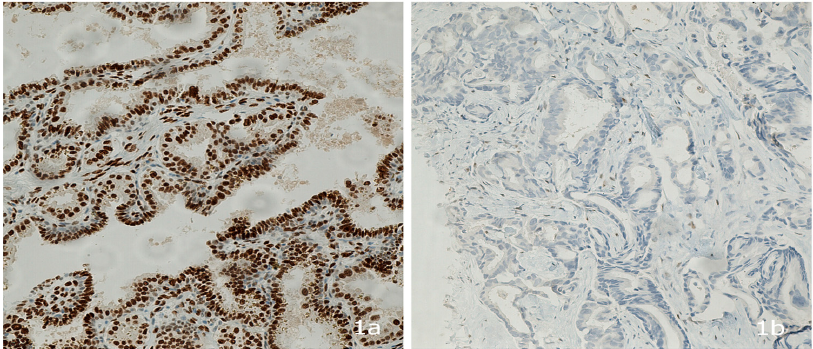
Figure 1. ( a ) Androgen receptor positive breast cancer. Stained androgen receptor in breast cancer tissue (brown color); and ( b ) androgen receptor negative breast cancer. There is no brown color staining in androgen receptor negative breast cancer